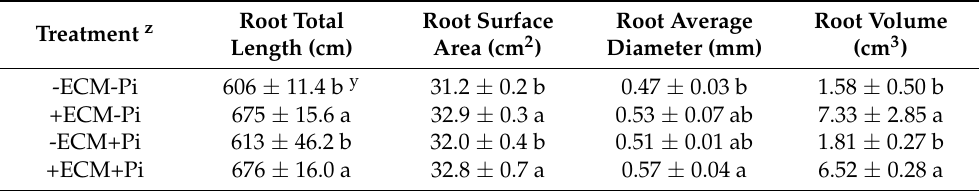
Table 1. The effects of ECMF and Pi levels on root architecture of C. henryi seedlings. Root Treatment z